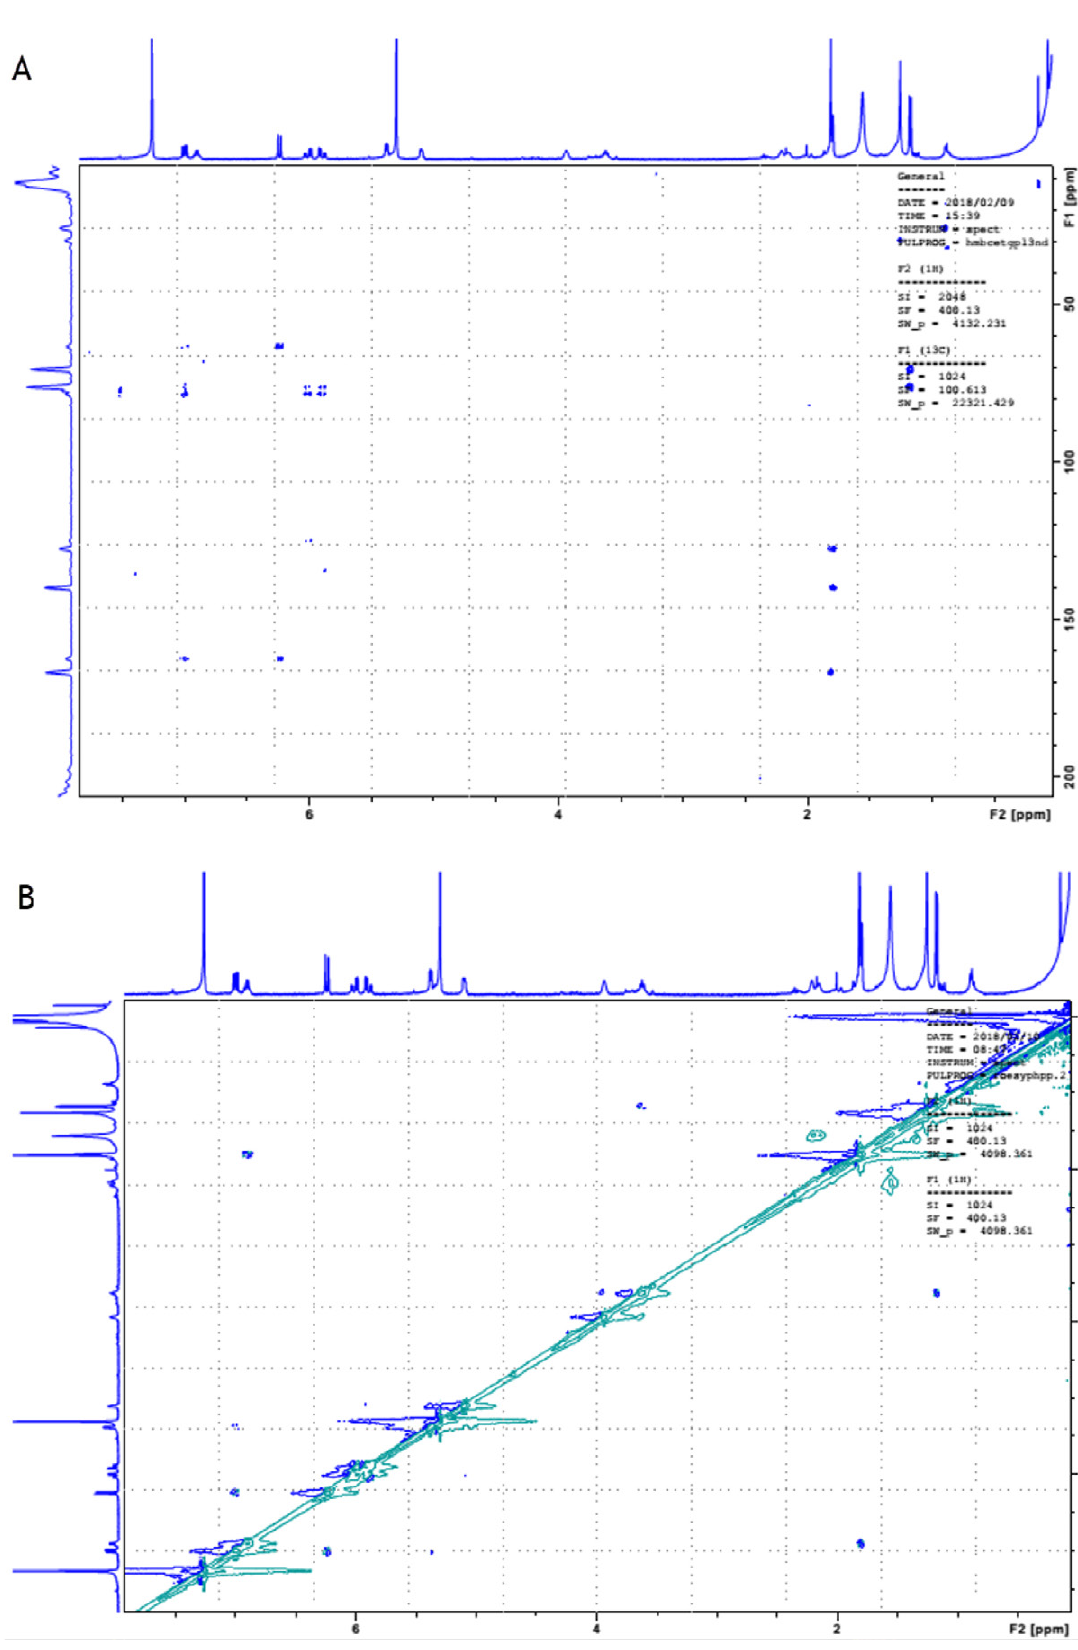
Figure 6. HMBC (A) and NOESY (B) spectra of compound